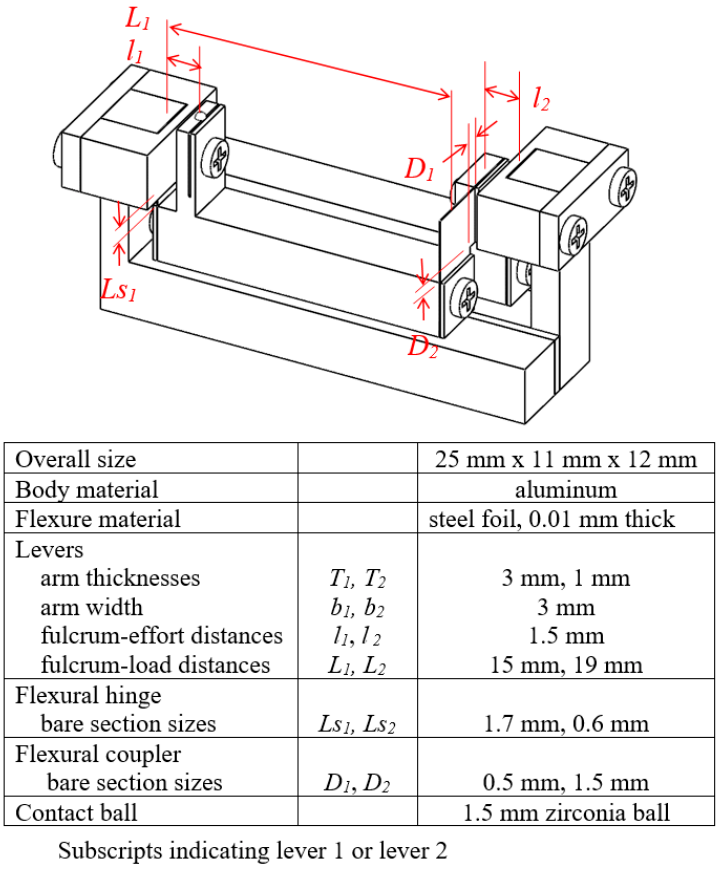
Figure 22. Layout and key dimensions of the MDMM compact model.